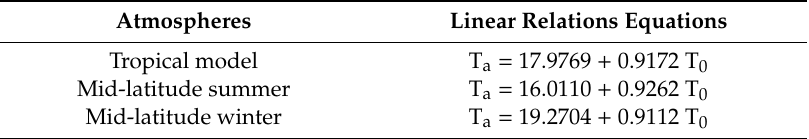
Table 4. Linear relations for the approximation of e ff ective mean atmospheric temperature (T a ) from the near surface air temperature (T 0 ).